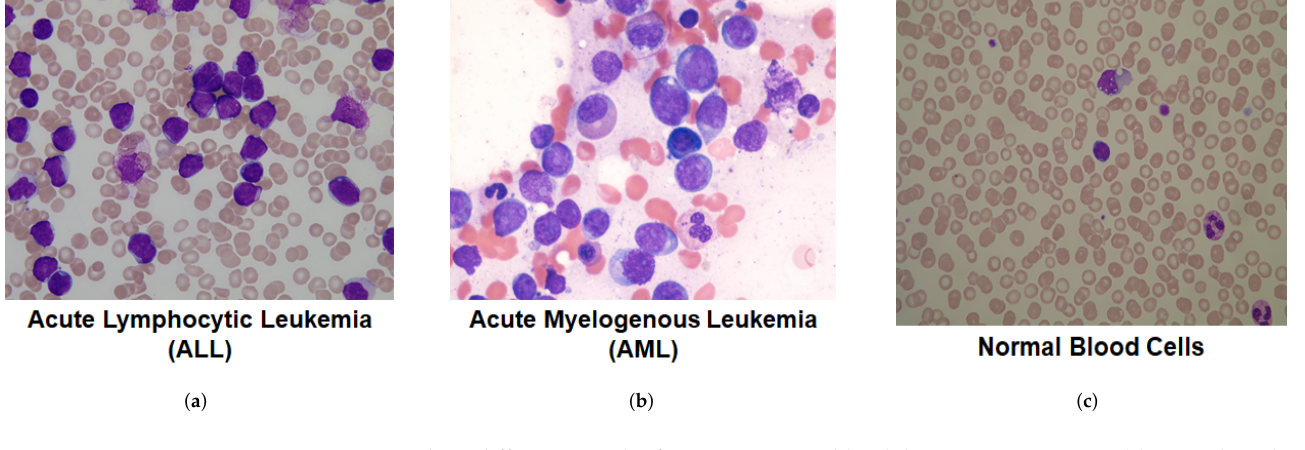
Figure 1. Three different samples from microscopic blood data set, representing: ( a ) Acute lympho- cytic leukemia; ( b ) Acute myelogenous leukemia; and ( c ) Normal blood cells. Table 1. Summary of microscopic image data sets for the different blood conditions considered in this